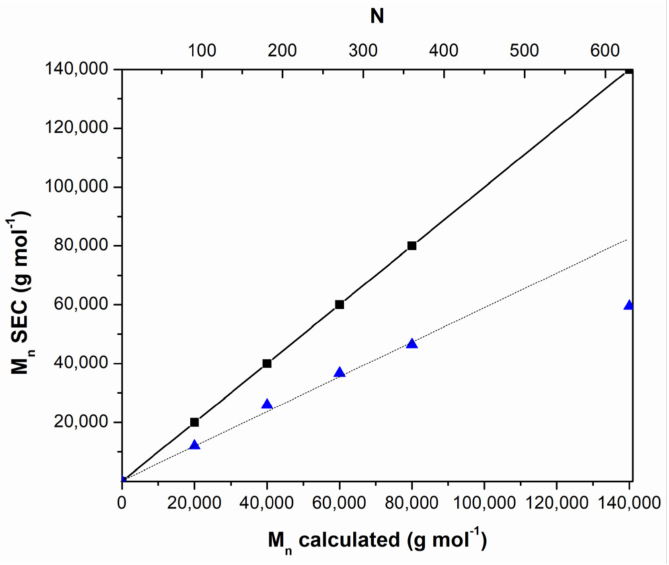
Figure 2. Correlation of experimental PIBOMA M n ( (cid:78) ), values from RI-detection, SEC in THF at 40 ◦ C) with calculated theoretical M n ( (cid:4) ) or calculated number of monomer equivalents N. The obtained PIBOMA samples represented powder-like materials with yellowish color, the latter being due to the utilization of yellow CDTPA agent. Their structure was confirmed by 1 H and 13 C NMR and IR spectroscopy (Figures S2 and S3). 1 H NMR shows three broad sets of signals at 4.62–4.16, 2.4–1.6 and 1.55–0.60 ppm attributed to the target polymer (Figure S2a). The residual protons for the end-groups from CDTPA RAFT agent were expected at 4.2, 3.7, 3.5 and 2.1–0.9 ppm, but cannot be seen in 1 H NMR due to the overlap with the signals coming from main chain and side isobornyl group. The peaks of the vinyl group from IBOMA monomer (6.05 and 5.50 ppm) were absent, proving the purity of the obtained polymers. The broad signals at 2.39–1.64 and 1.00–0.84 ppm were assigned to CH 2 and CH 3 groups of the polymer backbone, respectively (Figure S2a). The isobornyl group was represented by peaks at 4.45–4.2, 2.33–1.69, 1.54, 1.07 and 0.94–0.62 ppm,